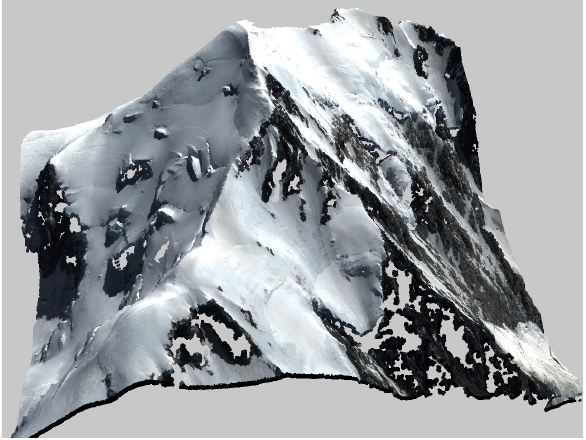
Figure 13: The summit of Mont Blanc, as computed by s2p. To obtain this point cloud, the user clicked a single time on the ap- propriate place of the